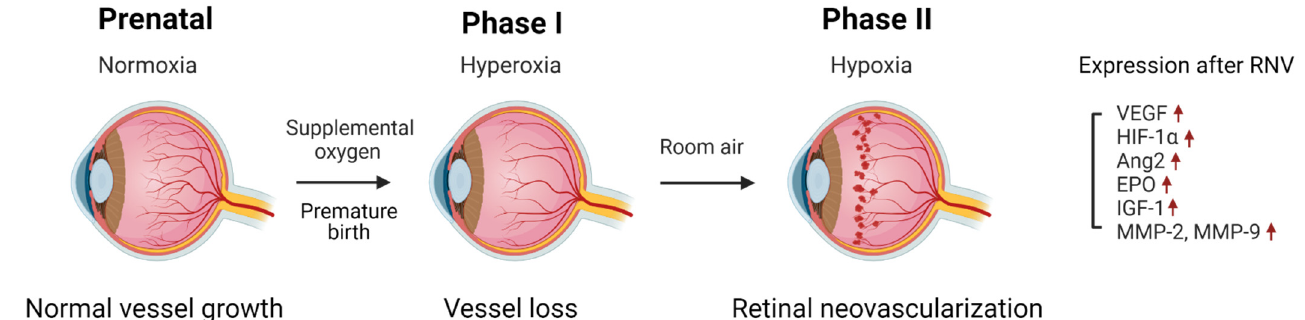
Figure 1. Pathogenesis of retinopathy of prematurity (ROP). Before a premature birth occurs, nor- mal vessels develop in utero. In phase I, premature infants are exposed to relative hyperoxia due to supplemental oxygen; as a result, normal vessel growth stops and vessel loss can occur. Addition- ally, premature infants no longer receive nutrients and growth factors from their mothers. In phase II, infants are placed back to room air, a relative hypoxic state. As a result, retinal neovascularization (RNV) is initiated, and hypoxia inducible factor-1 α (HIF-1 α ) vascular endothelial growth factor (VEGF) are activated. Moreover, the expressions of the genes encoding angiopoietin (Ang), eryth- ropoietin (EPO), insulin-like growth factor (IGF), and metalloproteinase (MMP) are